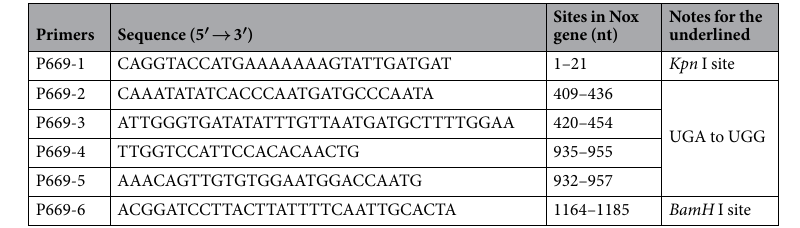
Table 2. Oligonucleotide primers used for amplification and site-directed mutagenesis of PGK